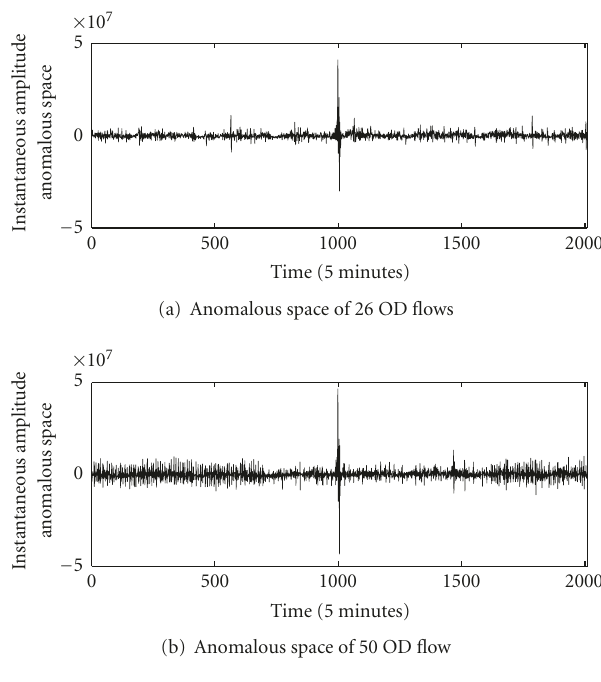
Figure 7: Anomalous space from instantaneous amplitude.